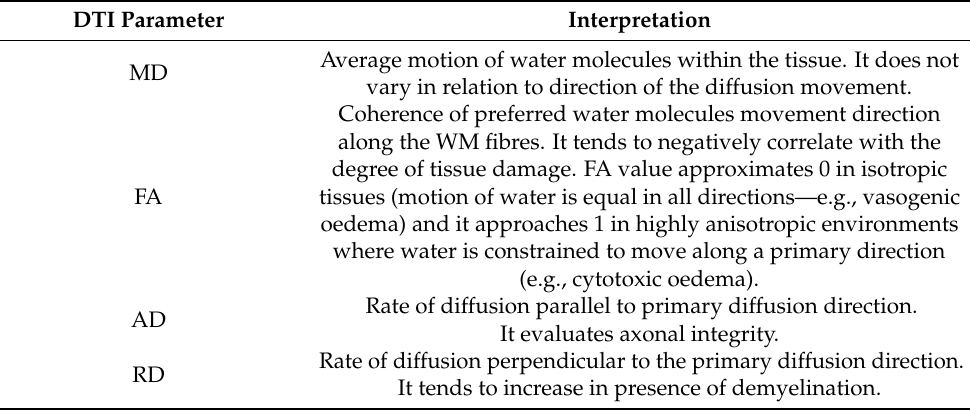
Table 2. Main DTI-derived parameters and their biological significance. DTI